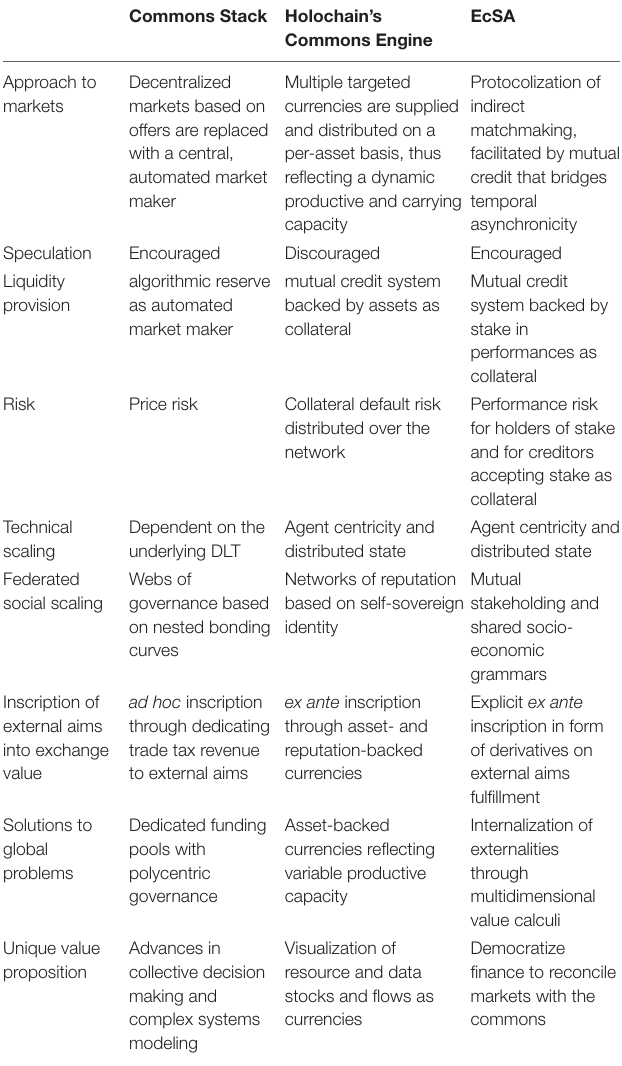
TABLE 2 | A comparison of the examined case